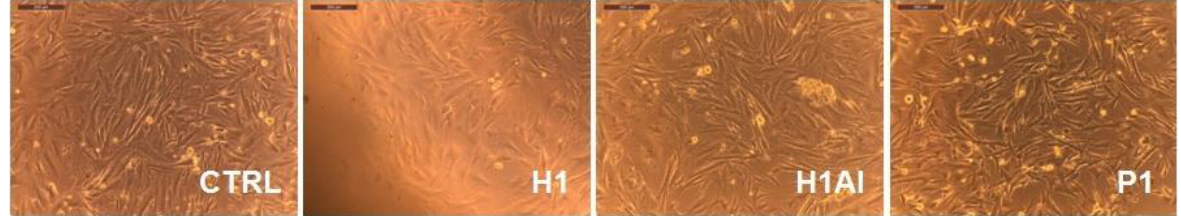
Figure 12. The appearance of the fibroblasts after 48h incubation with gels: H1, H1Al and P1 in comparison with the control (CTRL) sample.